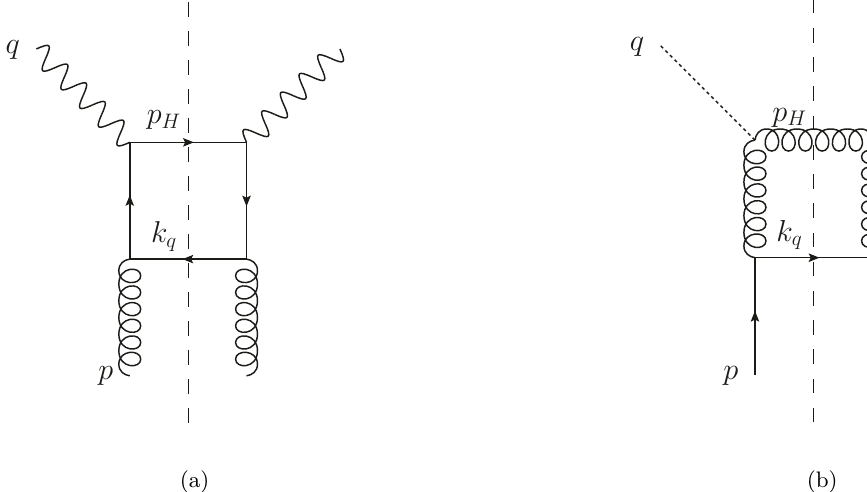
Figure 2. (a) NLO correction to DIS, where a gluon couples indirectly to the photon; (b) the analogous channel in Higgs-induced